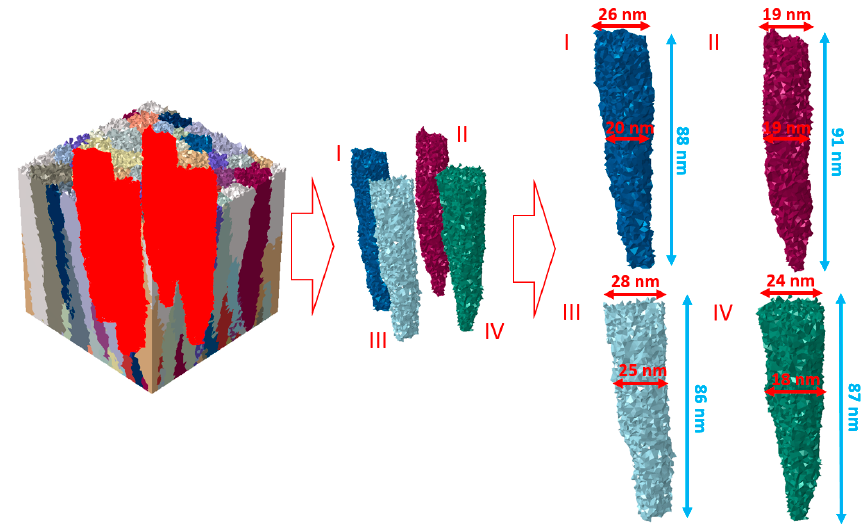
Figure 7. Dimensions of the columns obtained from PLD simulation.